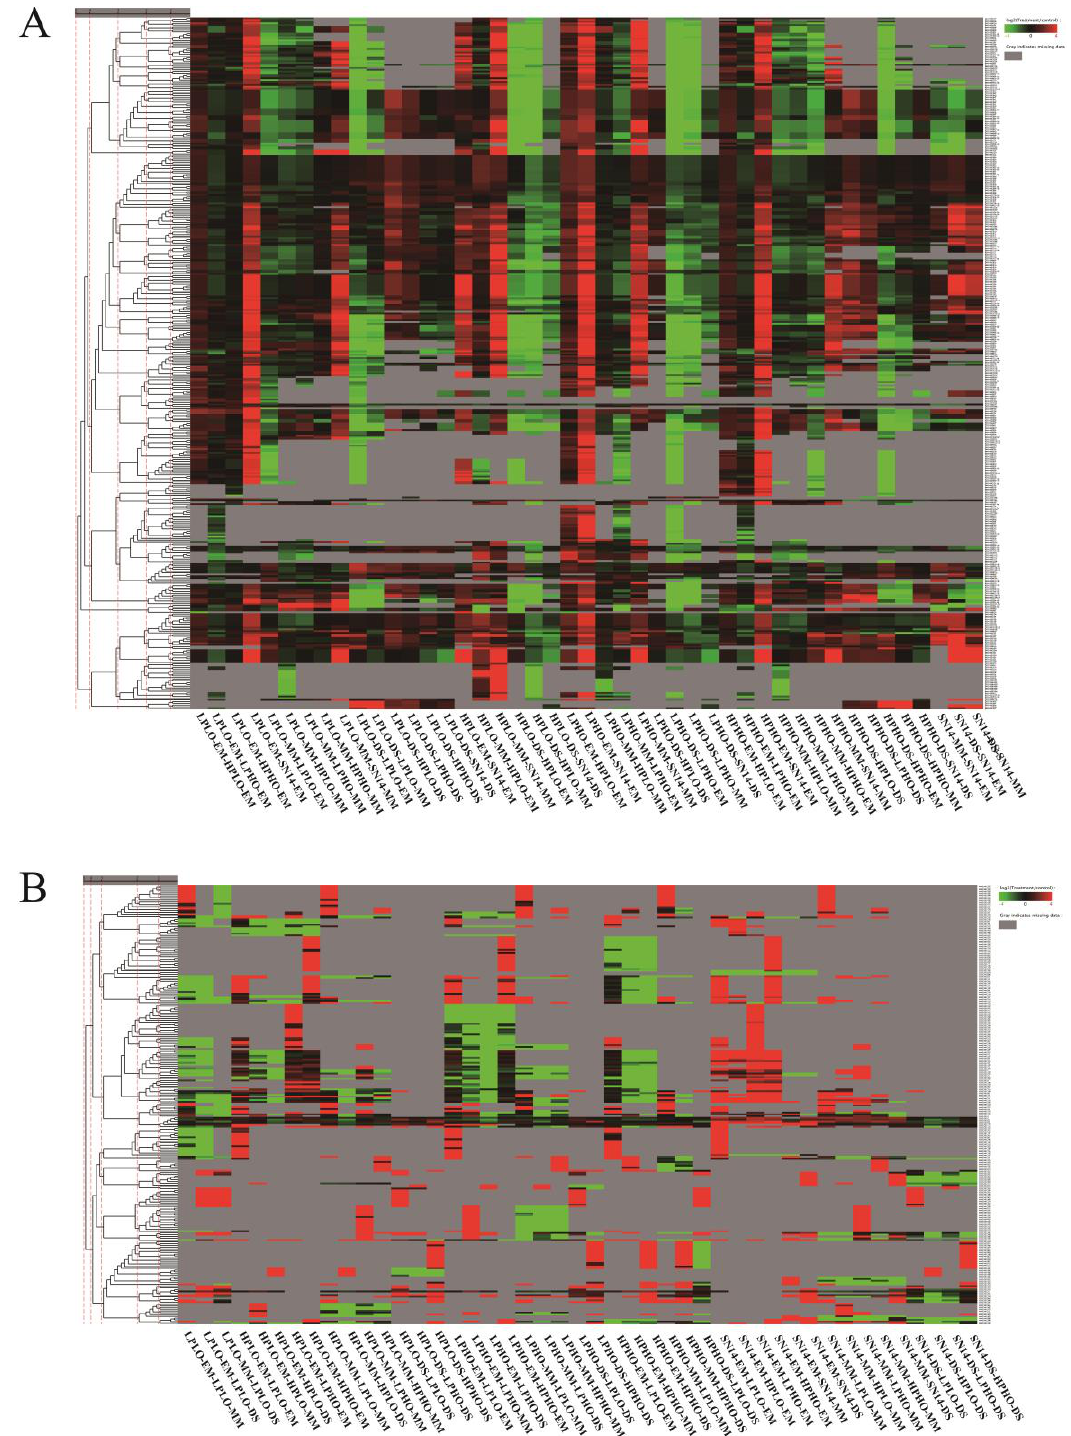
Figure 4. Cluster analysis of miRNAs with similar expression patterns. The heatmap showed miRNAs for each cluster that were significantly expressed in control, HPHO, HPLO, HOLP and LPLO at the EM, MM and DS stages, respectively. The Samples with miRNA expression levels higher than control material showed color red, the Samples with miRNA expression levels lower than control material showed color green, and the color gray indicates that the miRNA is not expressed in at least one sample. ( A ) Cluster analysis of known miRNAs, ( B ) Cluster analysis of novel miRNAs.